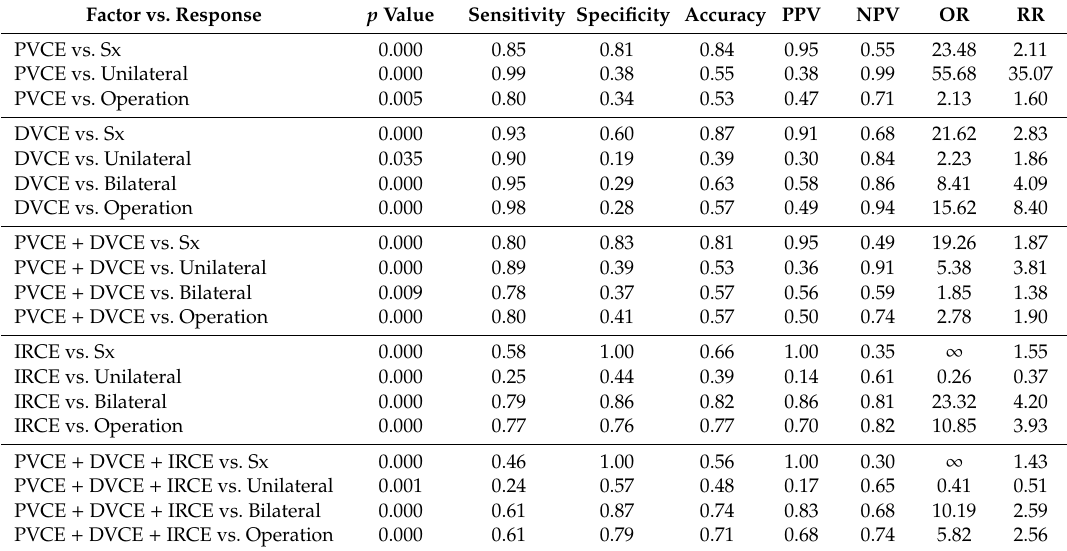
Table 3. Clinical meaning of PVCE, DVCE and IRCE. Factor vs.